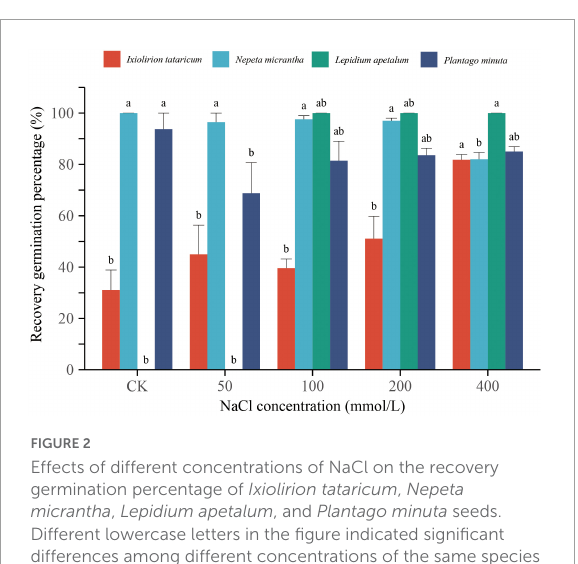
FIGURE2 Effects of different concentrations of NaCl on the recovery germination percentage of Ixiolirion tataricum , Nepeta micrantha , Lepidium apetalum , and Plantago minuta seeds. Different lowercase letters in the figure indicated significant differences among different concentrations of the same species ( P <